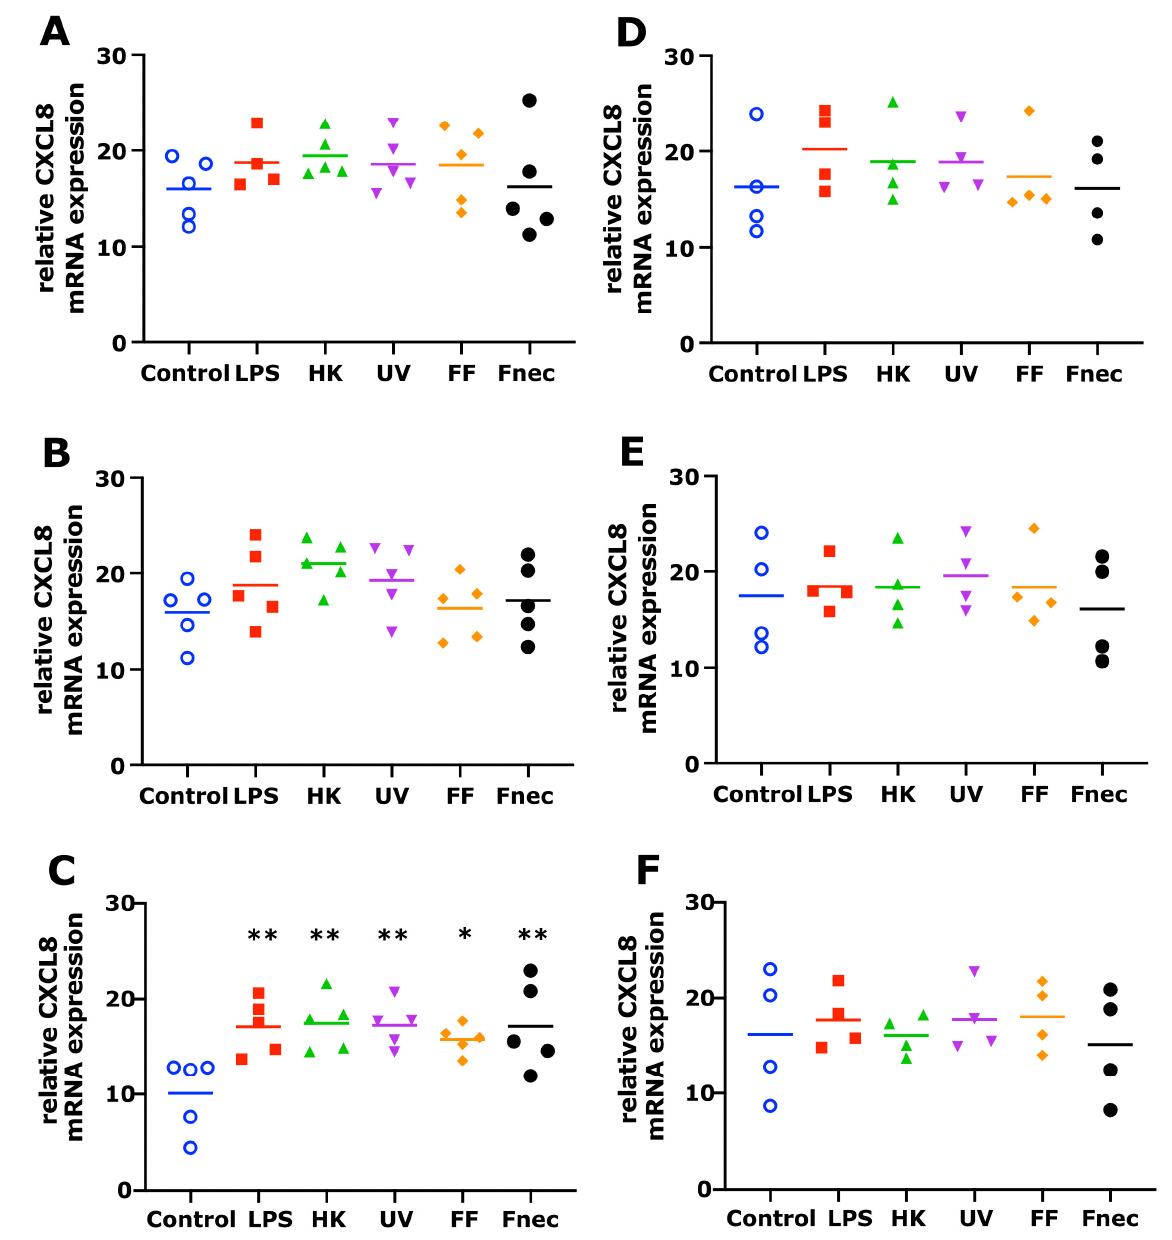
Figure 2. CXCL8 mRNA expression in interdigital ovine keratinocytes. Primary keratinocytes free of M. fermentans ( n = 5, ( A – C )) or naturally infected with M. fermentans ( n = 4, ( D – F )) were stimulated with 1 µ g/mL E. coli LPS, heat-inactivated D. nodosus (HK), UV-inactivated D. nodosus (UV), formalin-fixed D. nodosus (FF) or heat-inactivated F. necrophorum (Fnec) (cell culture medium was used as diluent and control) for 2 h ( A , D ), 8 h ( B , E ) and 24 h ( C , F ). Horizontal line indicates the mean. Each replicated symbol represents a different cell line from an individual sheep. One-way-ANOVA, followed by Dunnett’s multiple comparisons test: * p ≤ 0.05, ** p ≤ 0.01.